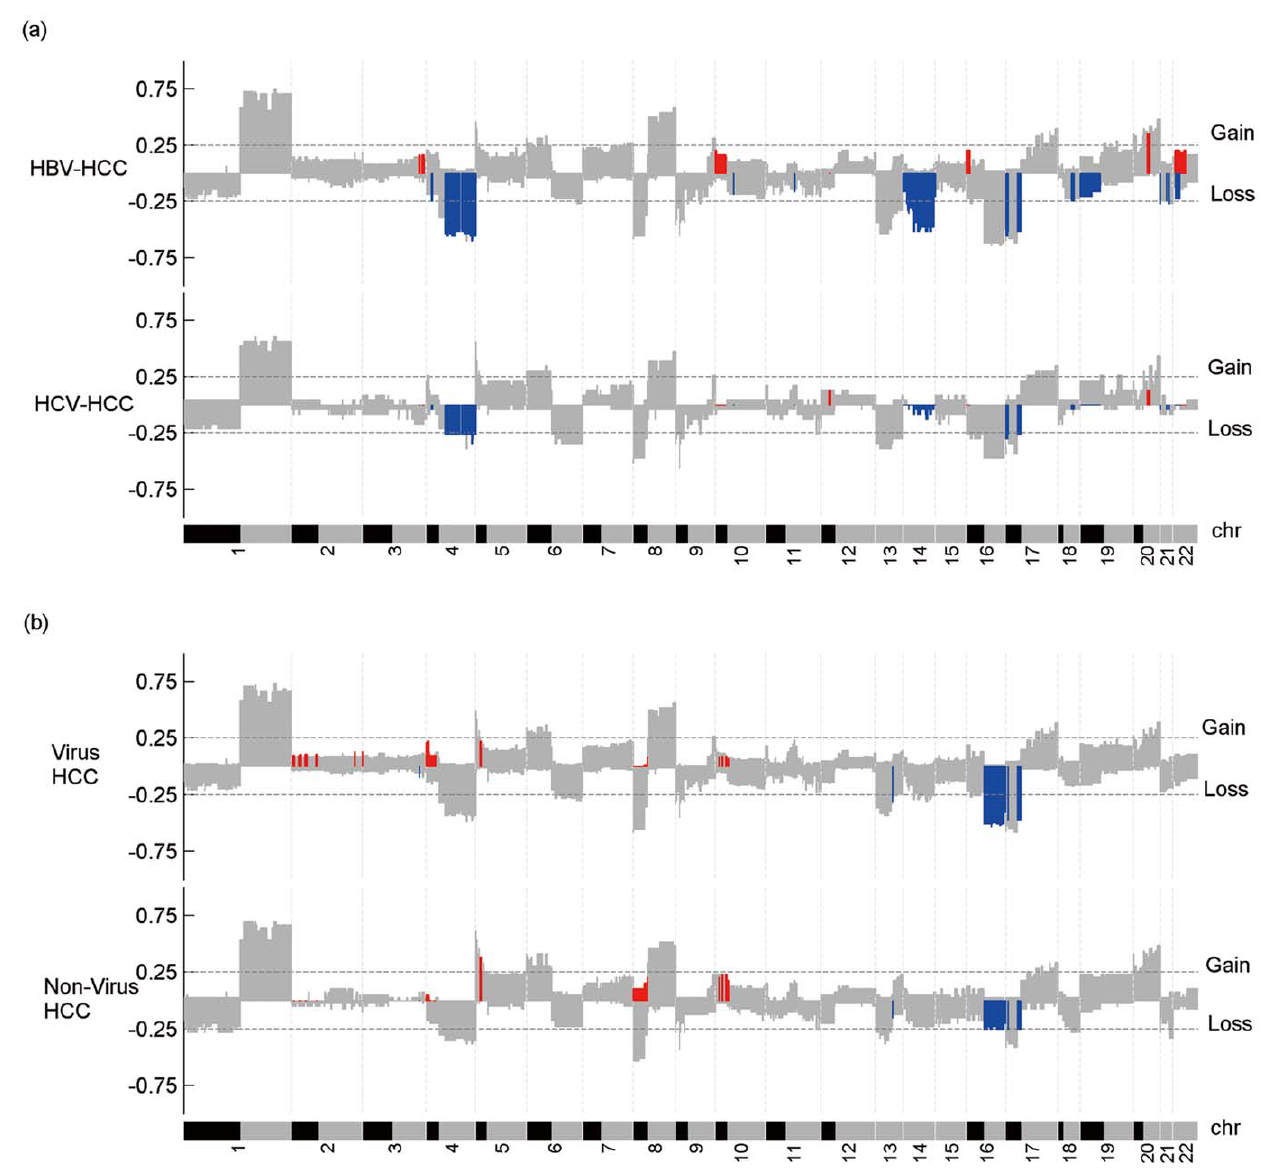
Figure 4. Profiles of etiology-related chromosomal aberrations in HCCs. (a). the comparison of chromosomal aberration profiles between HBV-related HCCs and HCV-related HCCs. (b) , the comparison of chromosomal aberration profiles between virus-related HCCs and non-virus-related HCCs. Copy number gains and losses with a significant difference in frequencies were highlighted in red and blue, respectively.